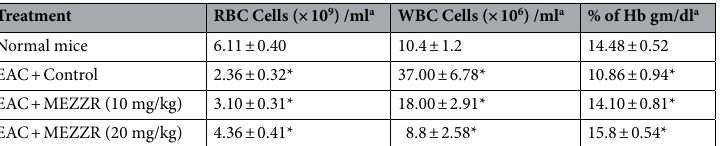
Table 4. Effect of MEZZR on blood parameters of EAC cell-bearing Swiss albino mice. a Data are expressed as mean ± SD for six animals in each group. *P < 0.05: against EAC control